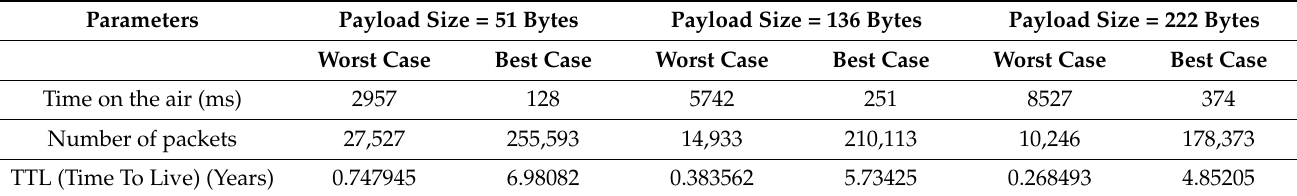
Table 9. Battery lifetime in the proposed protocol for low power authentication case 1 (16 bytes overhead due to secuirty). Parameters